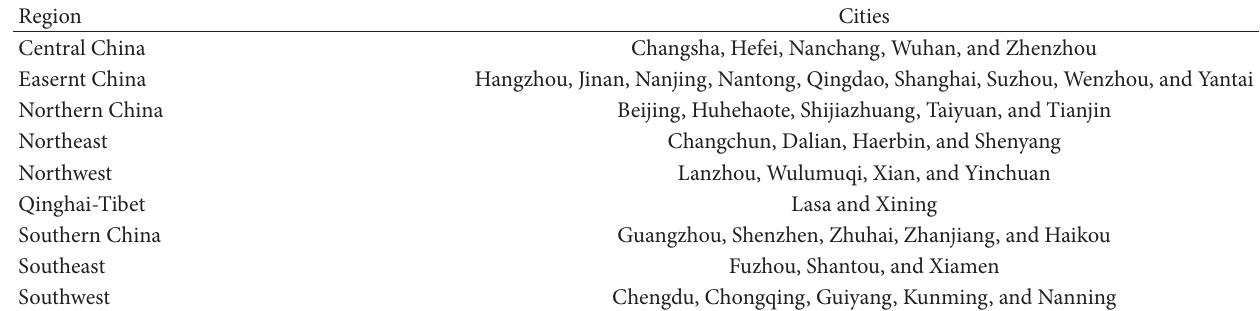
Table 1: Cities of study and corresponding